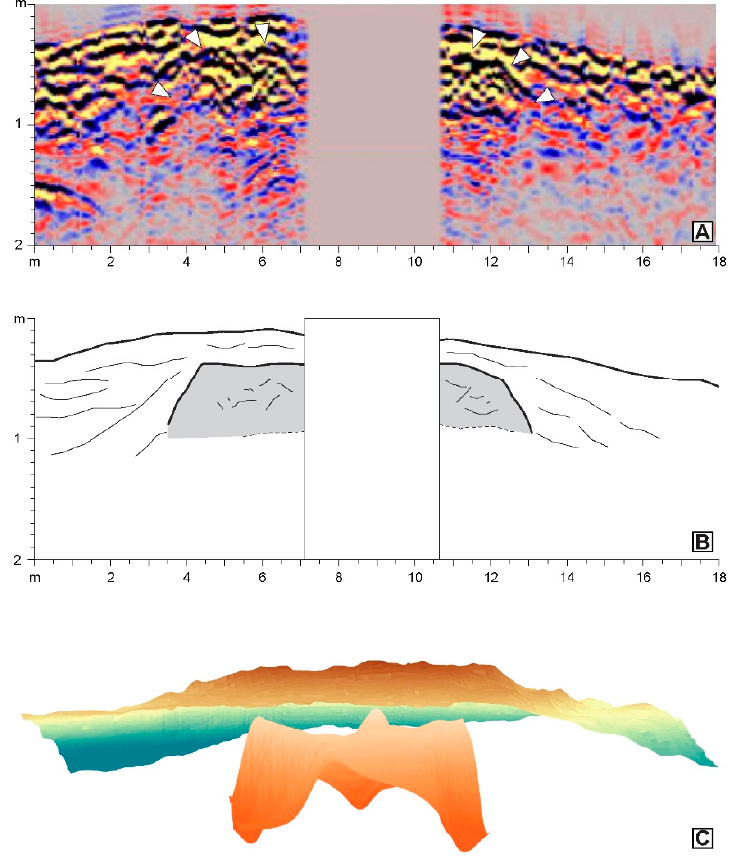
Figure 6. GPR section with the top of the stone core indicated by white triangles ( A ); GPR interpre- tation ( B ); 3D visualization of the topographic surface and the stone core (3× magnification) ( C ). For the location of the GPR section see Figure 4, profile a-a1.